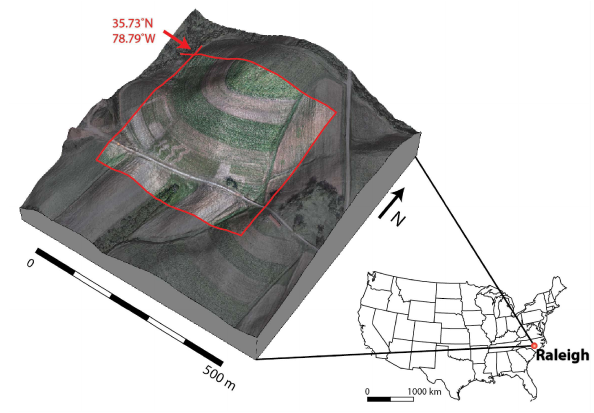
Figure 1: The targeted area, Lake Wheeler Road Field Laboratory of North Carolina State University, Raleigh,